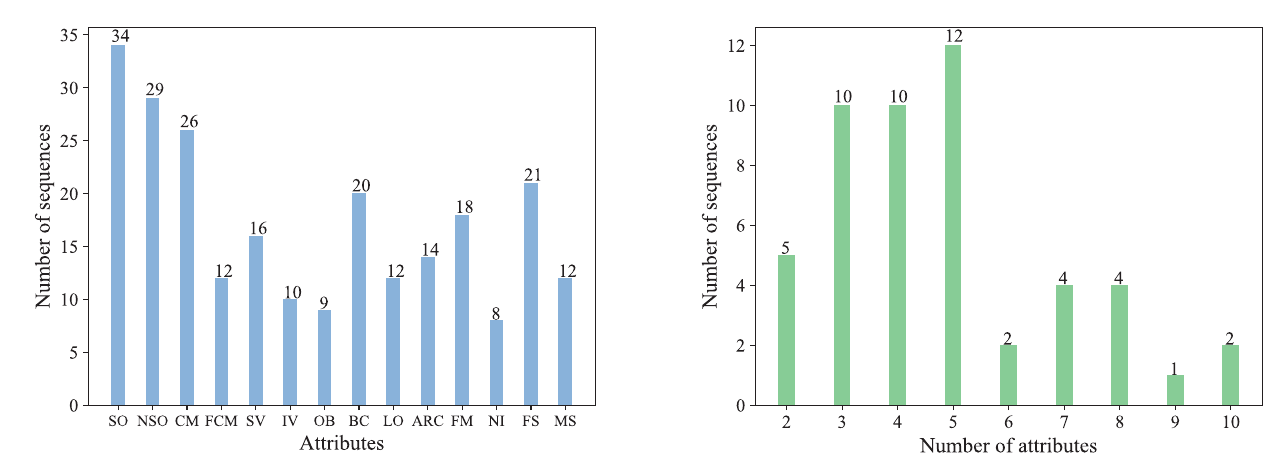
Figure 5. Attribute distribution of VIPUOTB.